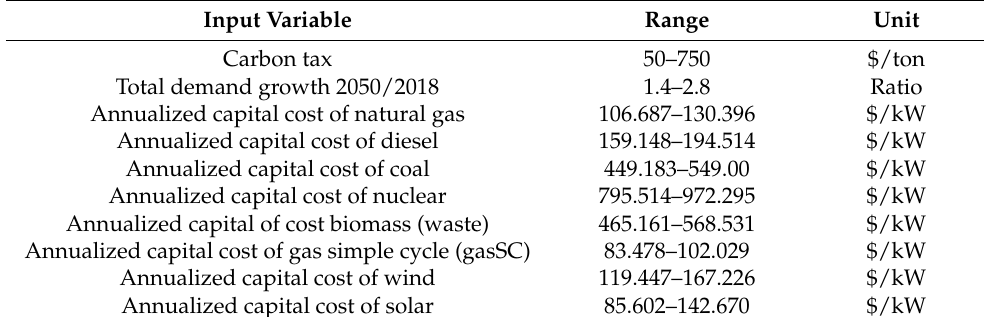
Table 1. Simulation dataset input range. The input values for running COPPER are randomly selected in each of these